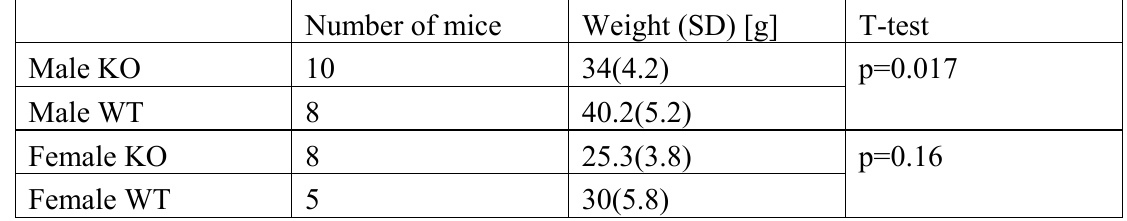
Table 1. Summary of animals in each group used in this study with their average